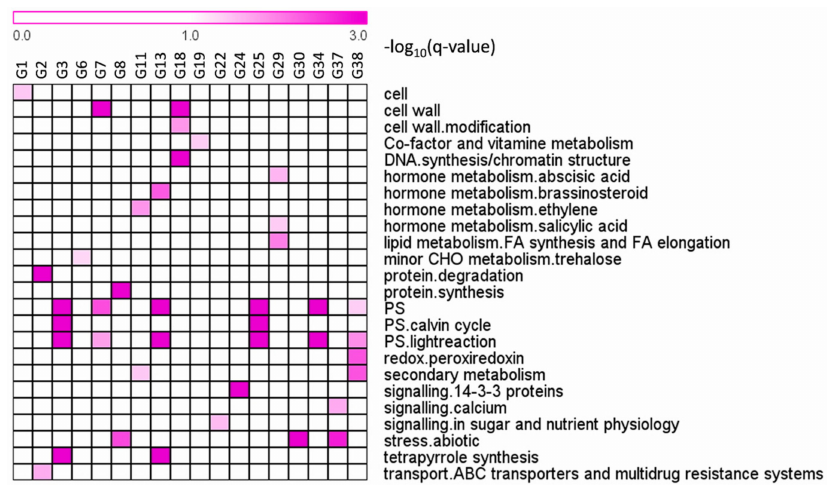
Figure 3. Functional category enrichment. Groups were indicated at the columns, while functional categories derived from MapMan annotation were indicated at the